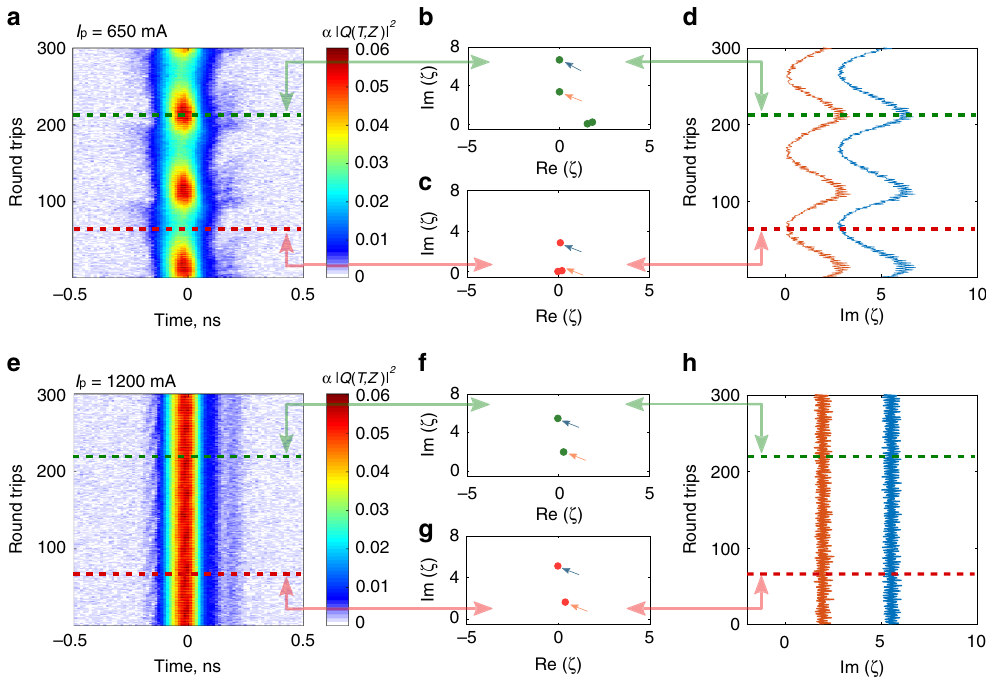
Fig. 2 Real-time NFT data evolution obtained from the measurement of the fi bre laser fi eld. a , e Real-time spatio-temporal dynamics of laser evolution obtained from full- fi eld measurements. a Corresponds to the pump current value I = 1200 mA ( (cid:7) I to the case I ). b , c , f , g Instantaneous NFT discrete spectra obtained at the round trips marked by horizontal coloured lines in ( a , e) . d , h p th Real-time evolution of the imaginary parts of two largest discrete eigenvalues indicated by arrows in ( a , e ).